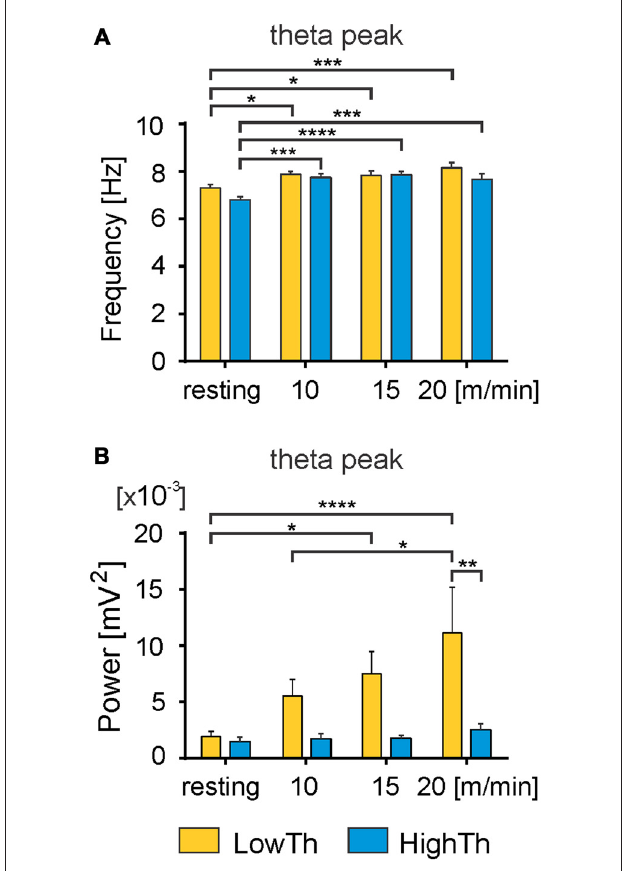
FIGURE 5 | Changes in frequency and power of the theta peak with the transition from resting state to locomotion. A significant increase in the frequency of theta peak was observed with the transition from resting to locomotion in both LowTh and HighTh animals (A) . Note significant increase in power of the theta peak in the LowTh group between resting and locomotion at 15 m/min and 20 m/min, and between 10 m/min and 20 m/min (B) . The power of the theta peak was significantly different when comparing LowTh and HighTh rats during locomotion at the highest speed (20 m/min). ∗ P < 0.05, ∗∗ P < 0.01, ∗∗∗ P < 0.001, ∗∗∗∗ P <